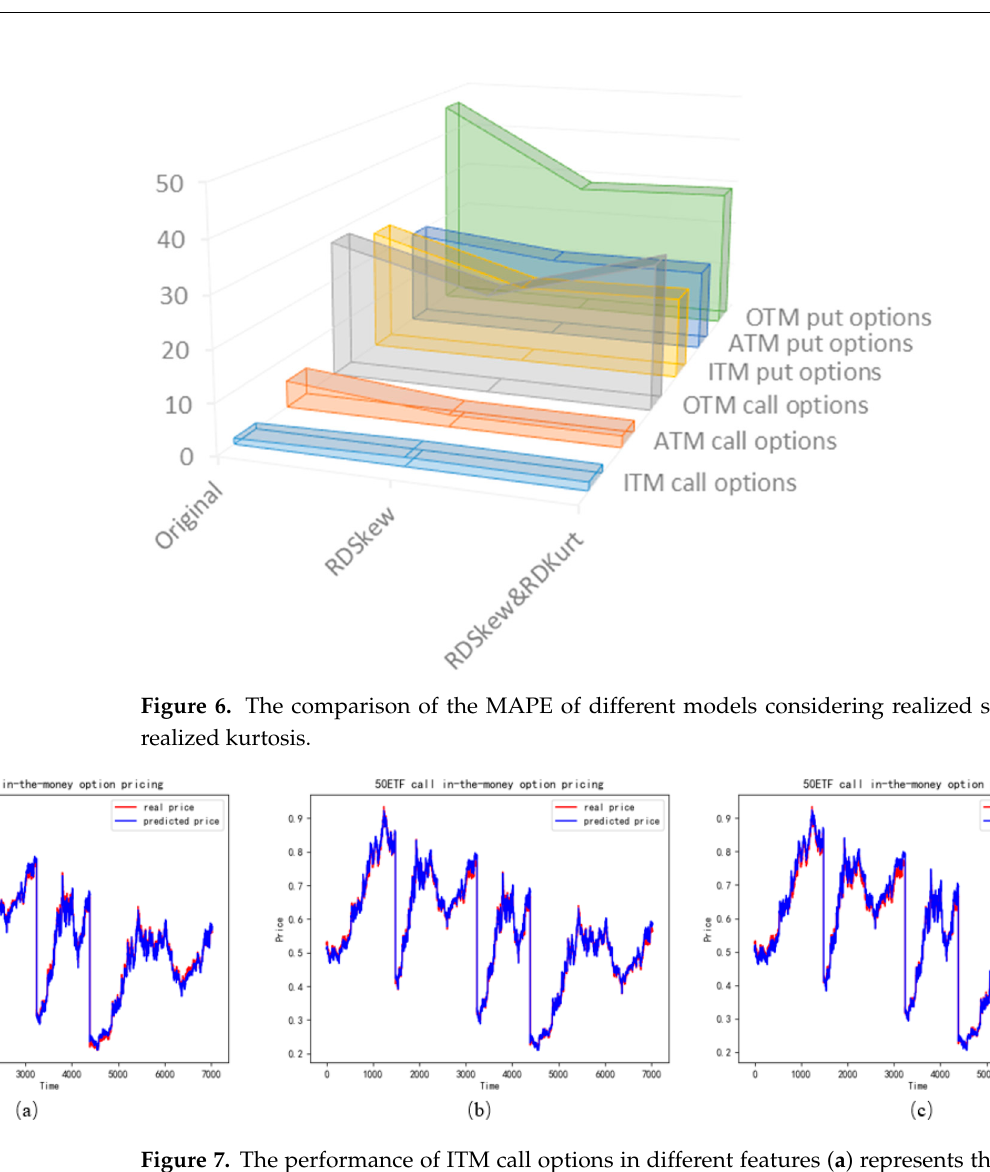
Figure 7. The performance of ITM call options in different features ( a ) represents the LSTM with realized skewness, ( b ) represents the LSTM without realized skewness, ( c ) represents the LSTM with realized skewness and realized kurtosis.